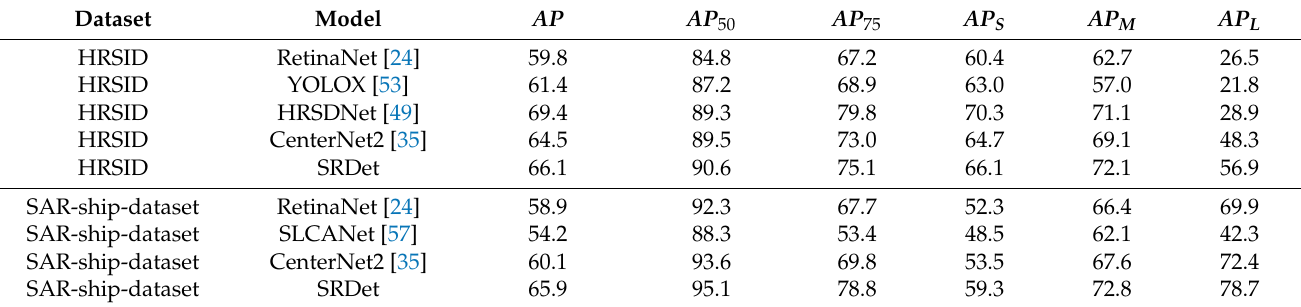
Table 11. Comparison with SAR ship detection methods on HRSID and